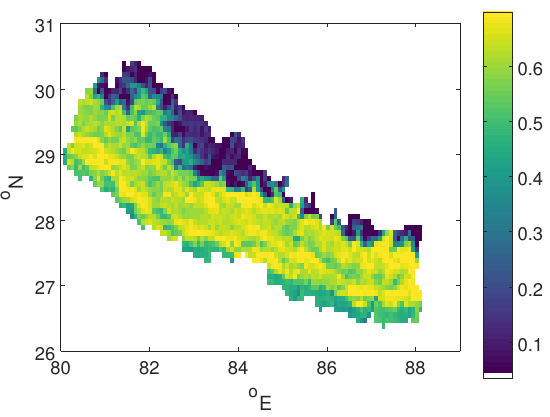
Figure 4. Mean normalized difference vegetation index (NDVI) by pixel over Nepal.